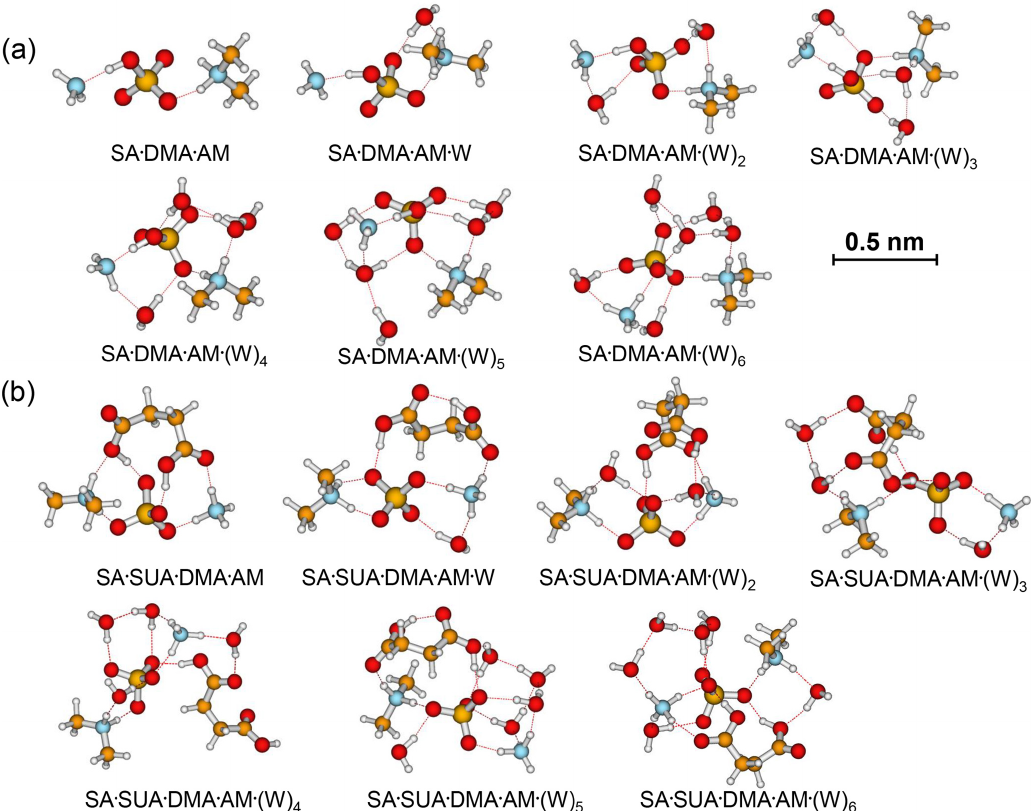
(cid:113) (cid:113) DMA AM clusters and the clusters with one SUA addition. The hydration is with